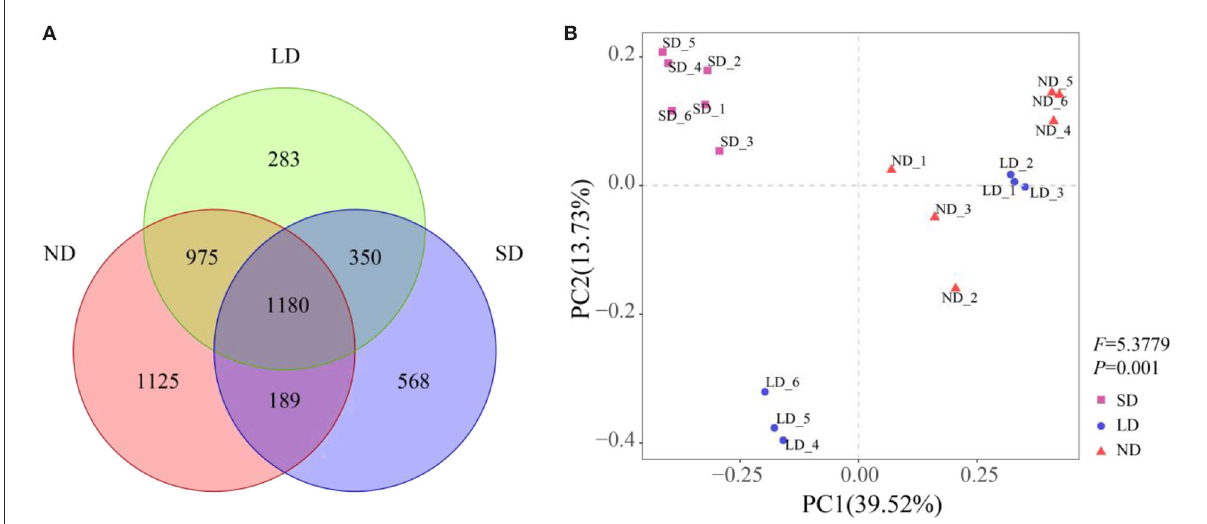
FIGURE3 Effect of degradation on the community composition of nitrogen-fixing bacteria. (A) Venn diagram of different degradation stages, different colors represent different degradation stages, and overlapping areas of different colors represent intersection points (that is, common OTUs appear in areas with overlapping colors, while non-overlapping areas show unique OTUs). (B) Application of principal coordinate analysis (PCoA) of nitrogen-fixing bacteria community based on the Bray-Curtis different similarity matrix in different degradation stages. Different shapes represent different degradation stages. The percentage of change explained by principal coordinates is displayed on the coordinate axis, and PERMANOVA results are displayed on the right side of PCoA. ND is non-degradation and LN and SD are the light and severe degradation stages of the alpine wetland,